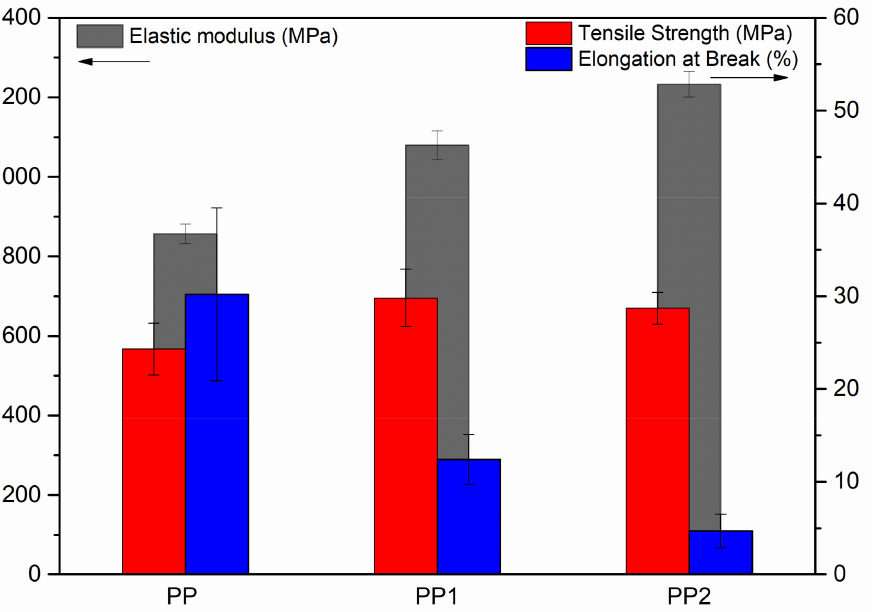
Figure 2. Histogram of elastic modulus, tensile strength and deformation at break of polypropylene and polypropylene